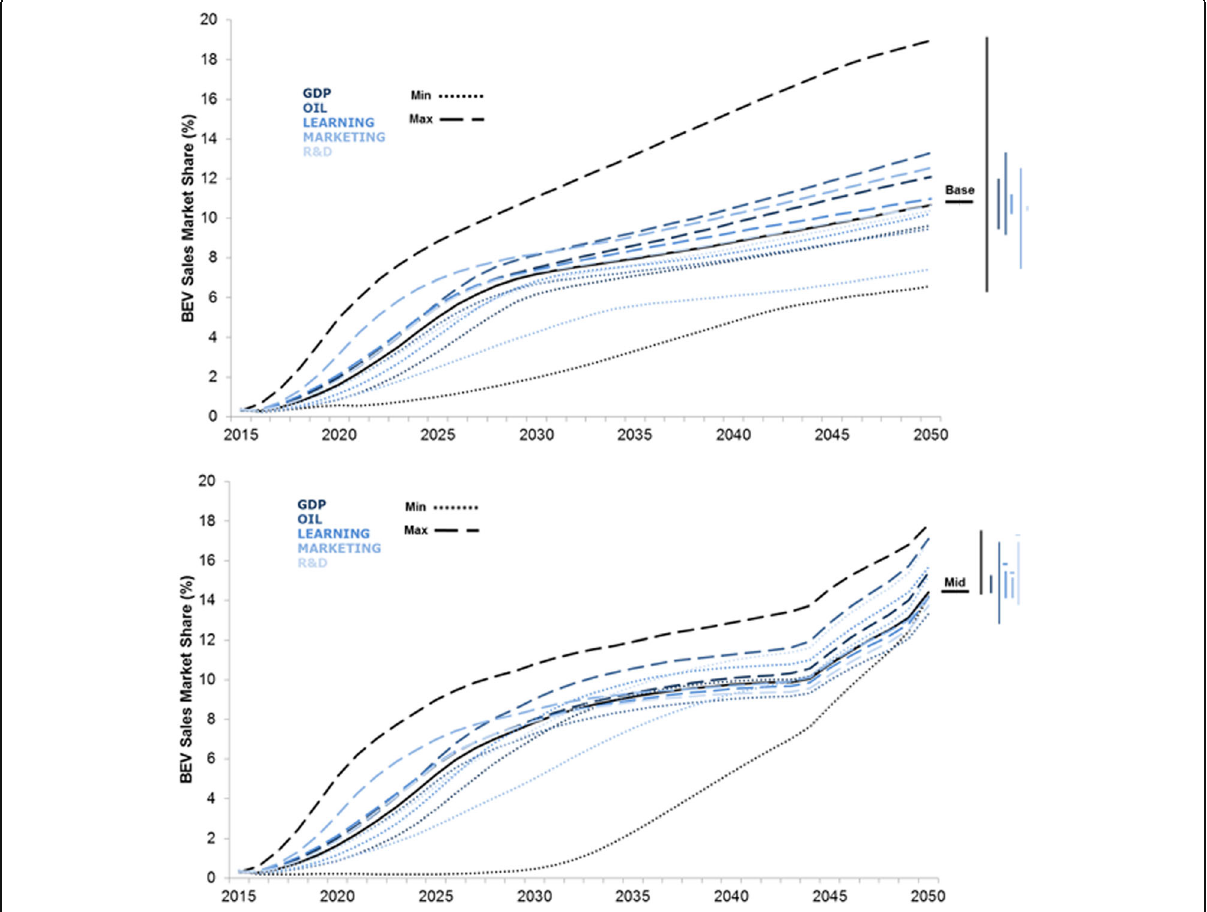
Fig. 3 EU 28 BEV sales share to 2050 under Base (top) and Mid (bottom) fleet emission targets, showing range between Min and Max